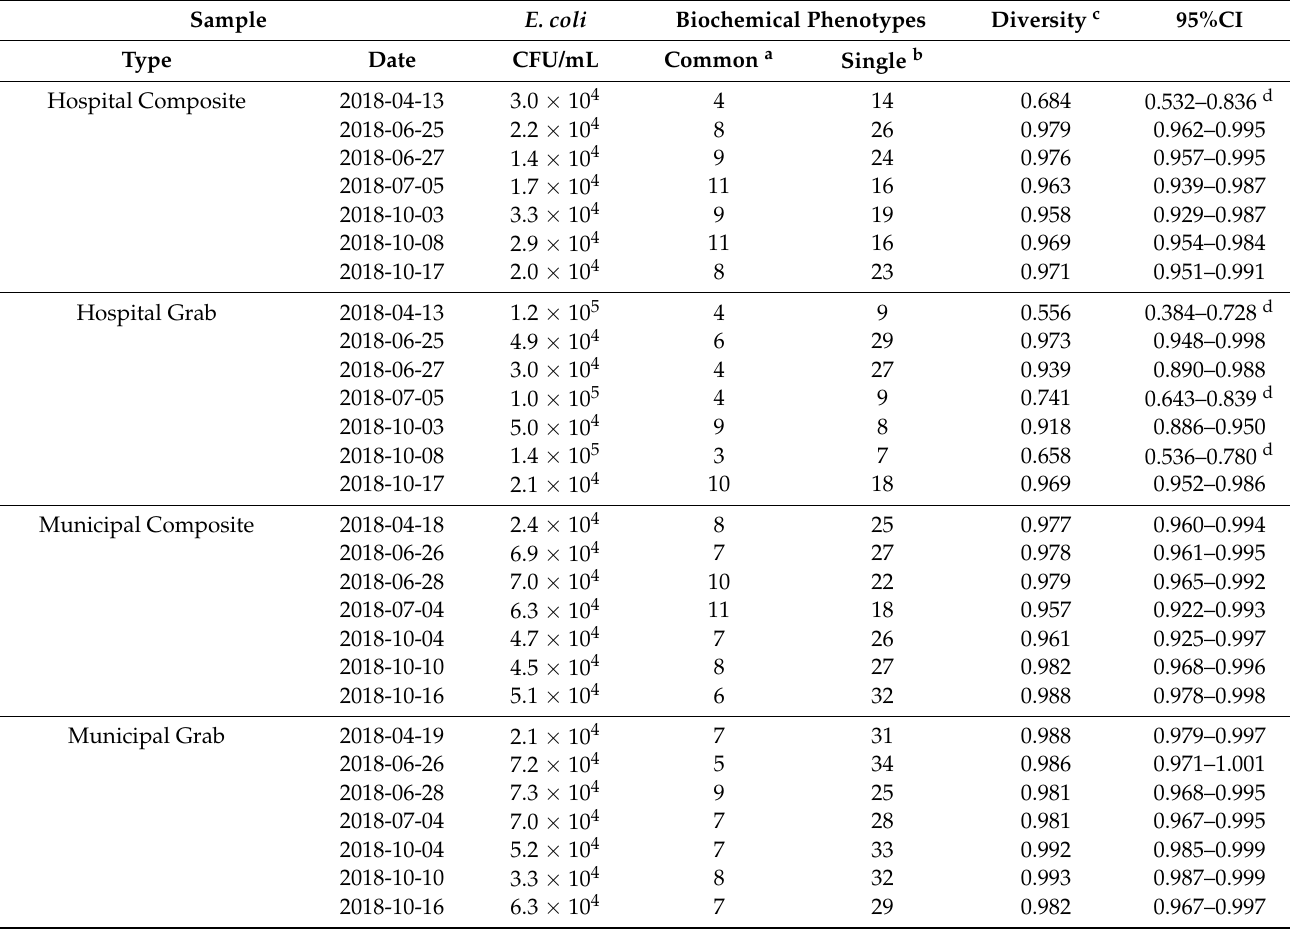
Table 1. Wastewater sample characteristics and E. coli